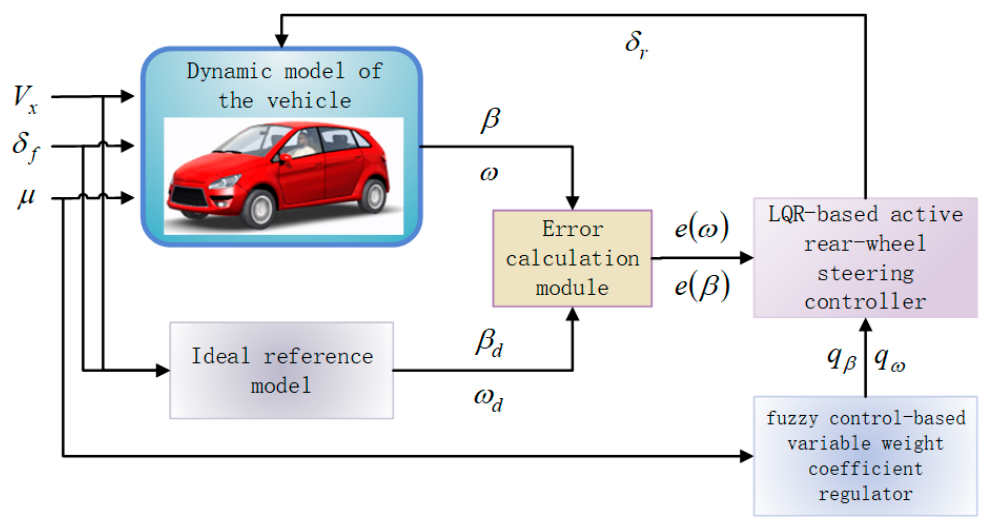
Figure 5. VLQR active rear-wheel steering controller.